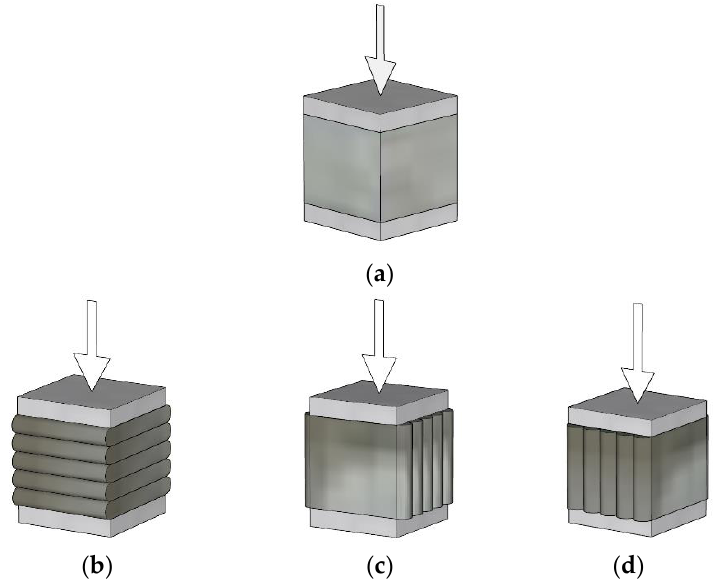
Figure 10. Compressive strength tests with different loading directions. ( a ) Monolithic specimen; ( b ) Loading direction I; ( c ) Loading direction II; ( d ) Loading direction III.